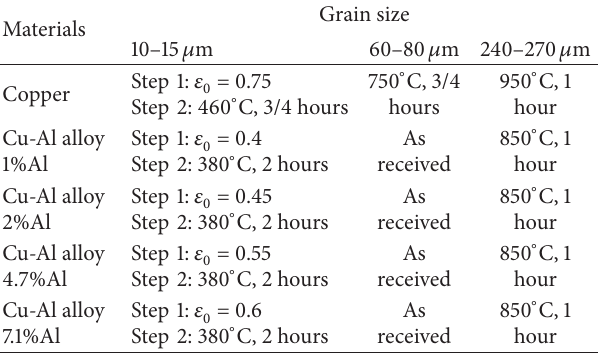
Table 2: Heat treatments employed to achieve three grain sizes for all materials; 𝜀 0 is the precold deformation in plane strain compression given to the materials before annealing for the small grain